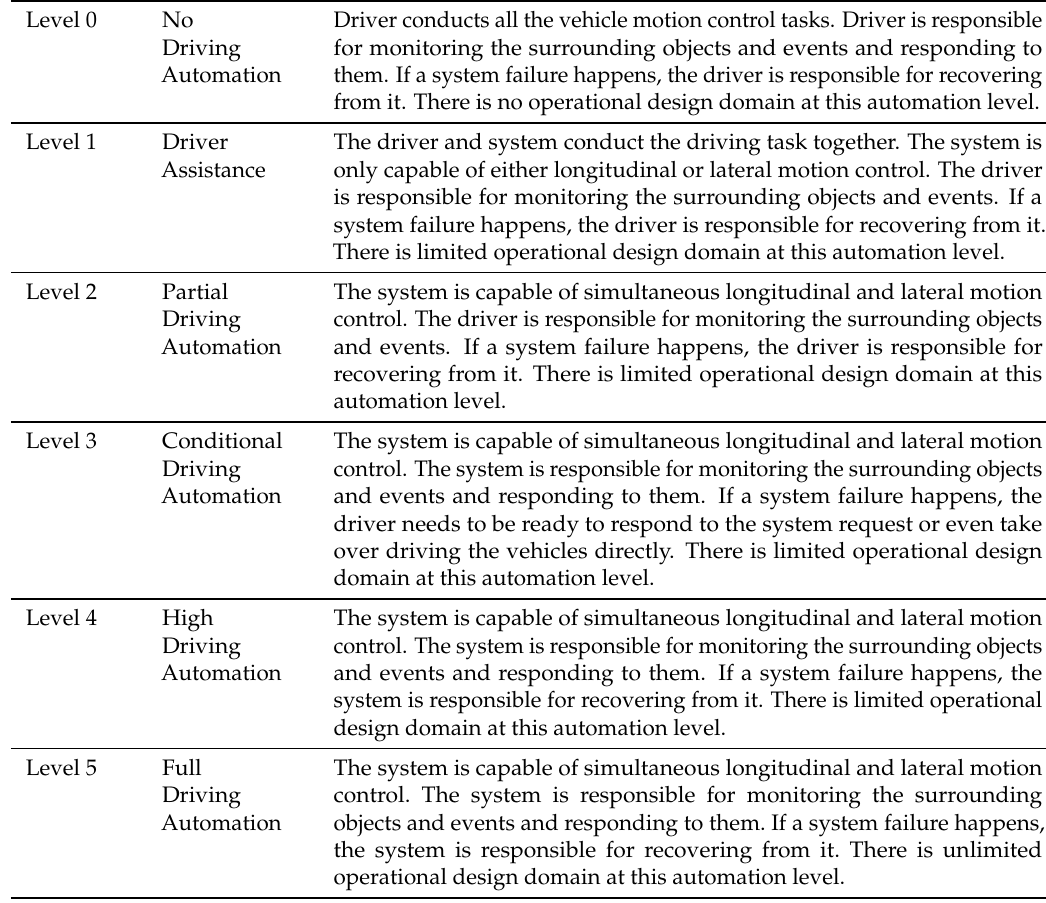
Table 1. Details of Society of Automotive Engineers (SAE) automation levels (modified from